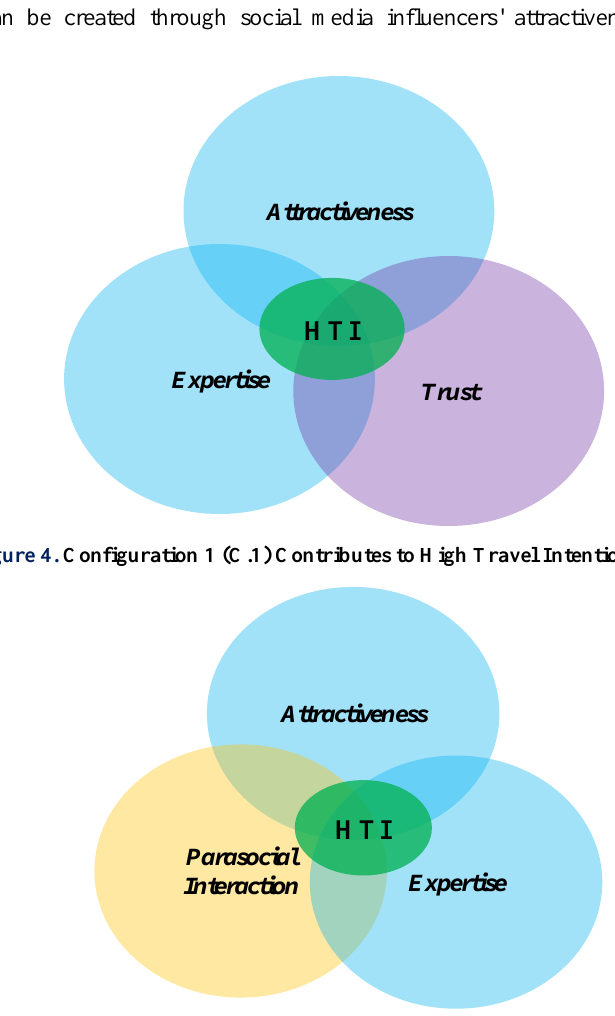
Figure 5. Configuration 6 (C.6) Contributes to High Travel Intention (HTI)